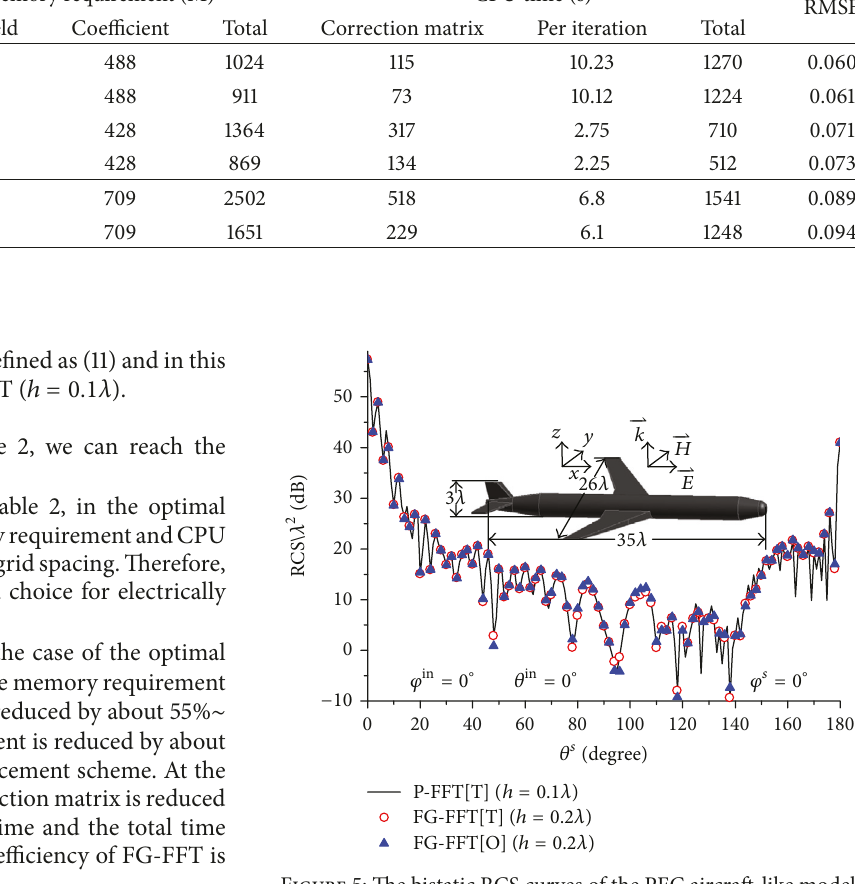
Figure 5: The bistatic RCS curves of the PEC aircraft-like